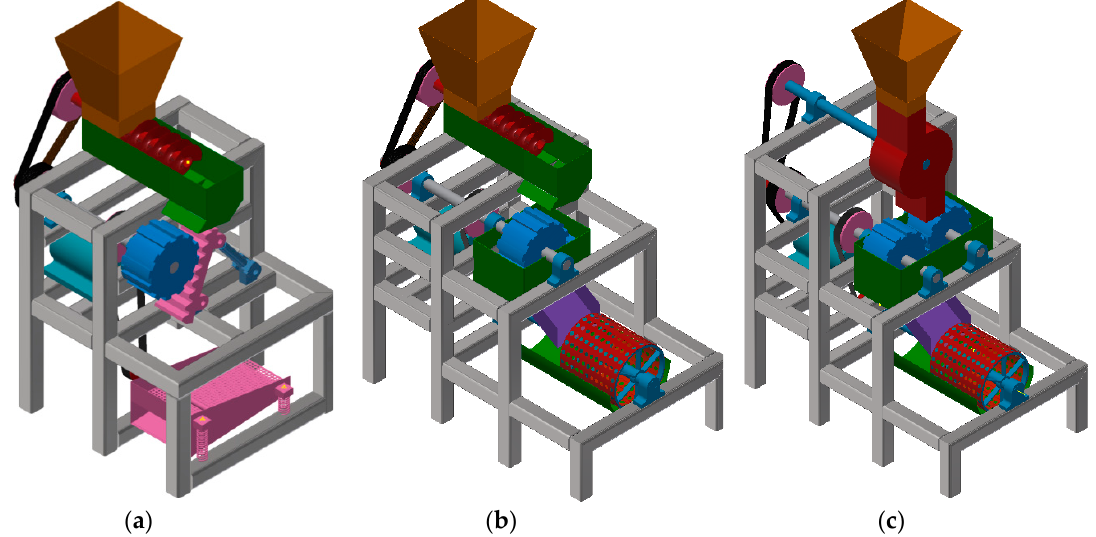
Figure 7. Three solution concepts according to the combination of functions presented in the morphological matrix; ( a ) a conceptual design based on toothed cylinder and wall mechanism; ( b ) based on toothed wheel and curved toothed wall mechanism; ( c ) based on two toothed cylinders.